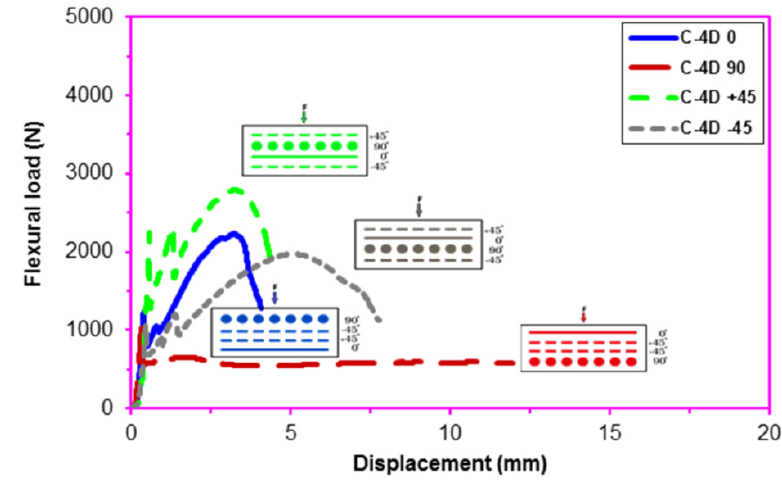
Figure 10. General characterization of the off-axis flexural load-displacement curves of C-4D con- crete composite. Table 4. Average flexural test results on the multiaxis 3D carbon fiber concrete composites.